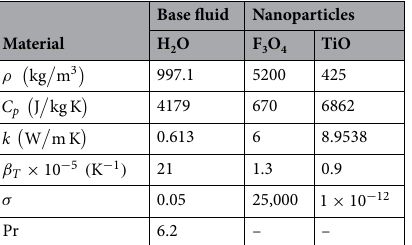
Table 2. Physical values of thermal properties of nanoparticles and base fluid.